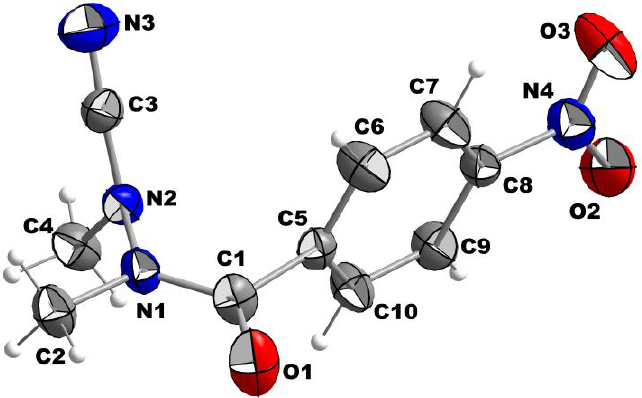
Figure 1. The molecular structure of Compound 2 as observed in the crystal state.